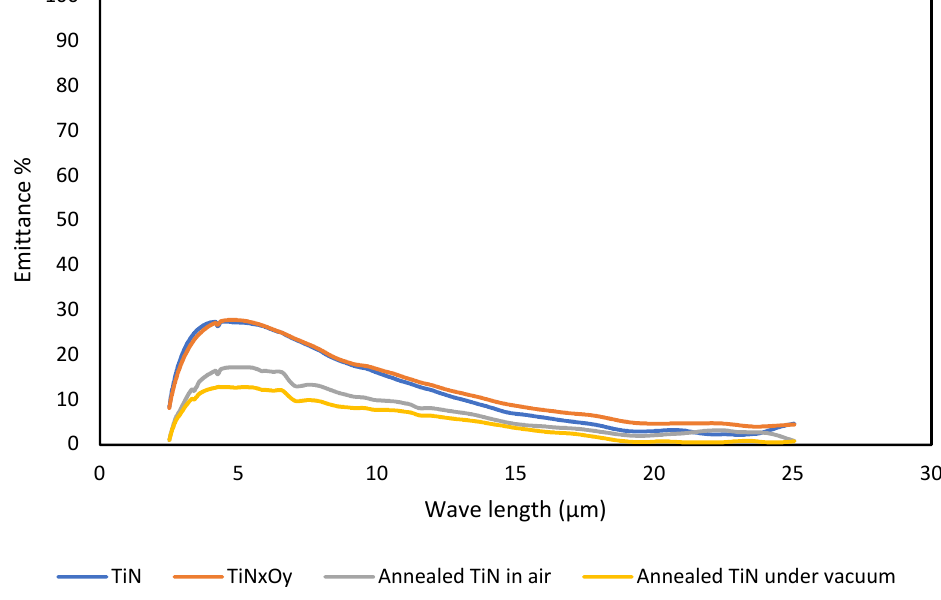
Figure 5. Emittance of TiN, TiN x O y , annealed TiN in air, and vacuum.